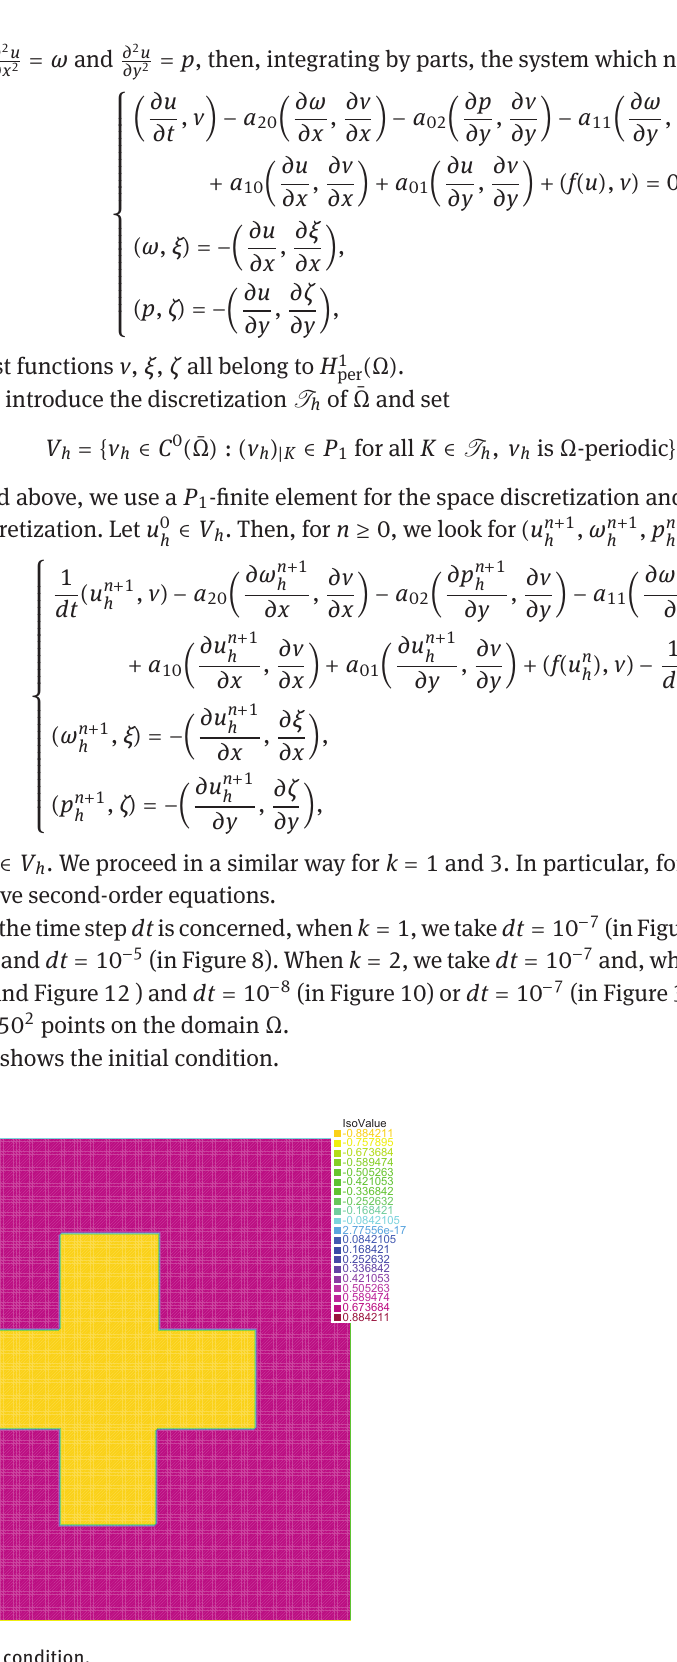
Figure 2: Initial